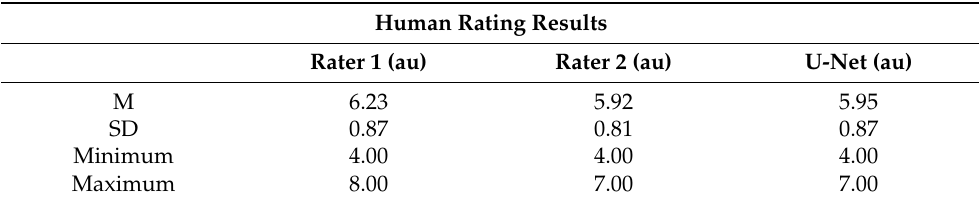
Figure 5. Automatic segmentation of the left (red) and right (green) OB in coronal T2 MRI scan performed manually by two independent raters and the algorithm. Table 5. Human validation scale. This table shows the manual rating criteria used by blinded rater for human validation of the segmentations. The rating scale was defined as: 1: “No congruency”, 2–3: “Poor congruency”, 4–5: “good congruency”, 6–7: “very good congruency”, 8–10: “excellent congruency.” The unit (au) means arbitrary